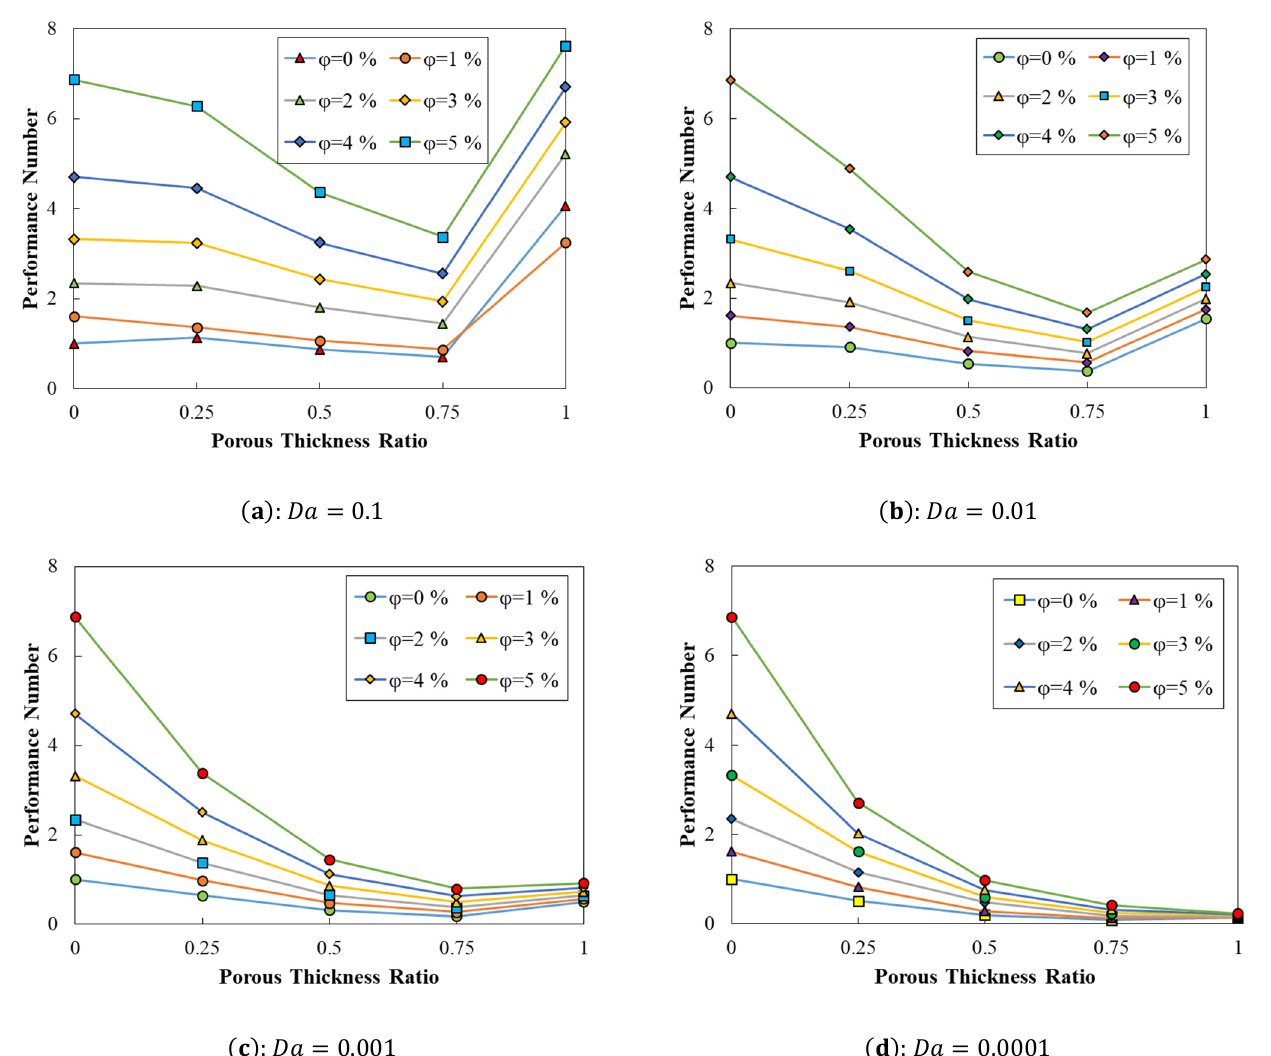
Figure 8. Performance number versus porous thickness ratio for diverse volume fraction at different Darcy numbers (case